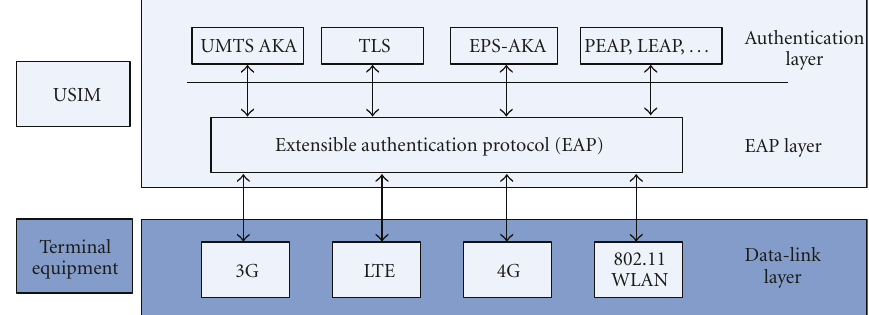
Figure 10: EAP framework in